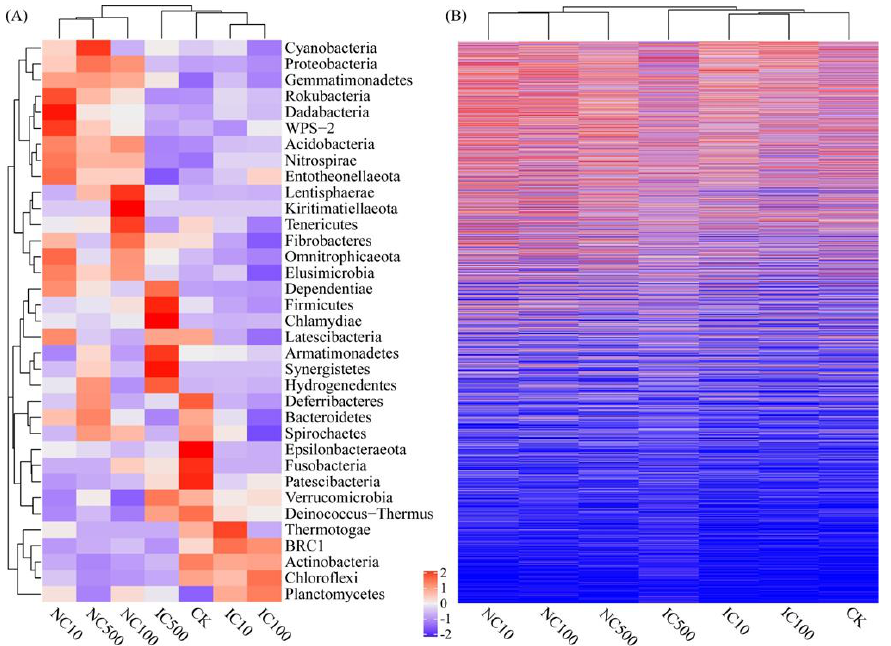
Figure 2. Hierarchical clustering heatmaps based on bacterial community at phylum ( A ) and OTU ( B ) level. The heatmaps are based on the normalized taxa relative abundance data. Warmer color (red) indicates a higher taxa abundance, while colder color indicates a lower taxa abundance. Microorganisms 2021 , 9 , x FOR PEER REVIEW